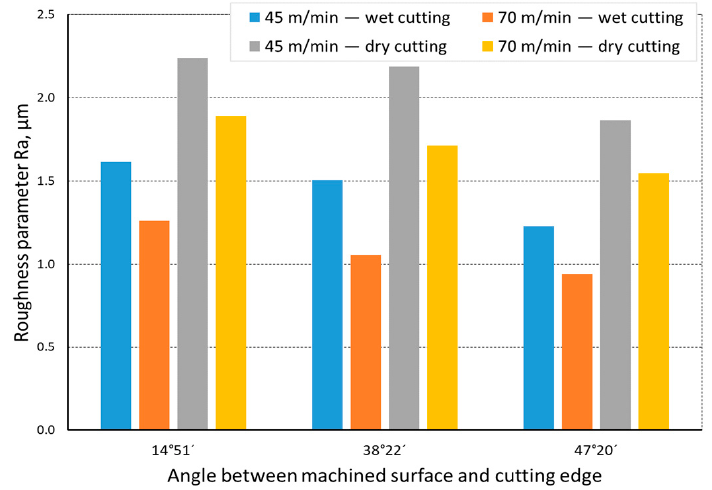
Figure 8. The impact of cutting speed on the variability of roughness parameter Ra in the function of the angle between the machined surface and cutting edge for a curvilinear track and a material hardness of 23 HRC.